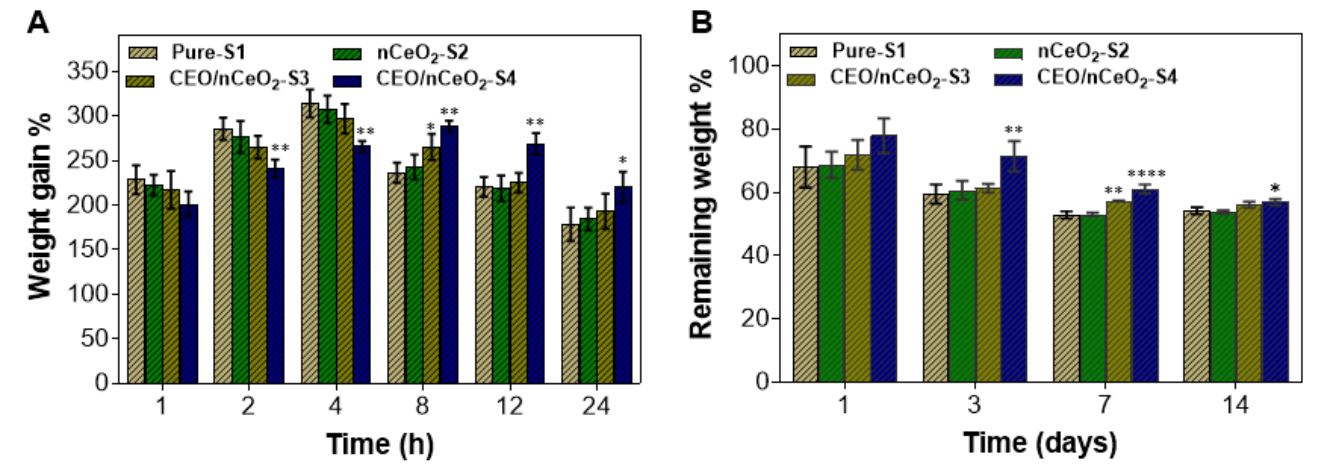
Figure 3. Water absorption, swellability ( A ), and biodegradability properties ( B ) of the developed dual spinneret electrospun Pu/PVA-Gel mats. Data are expressed as average ± SD. * p < 0.0332; ** p < 0.0021, **** p < 0.0001, versus control.